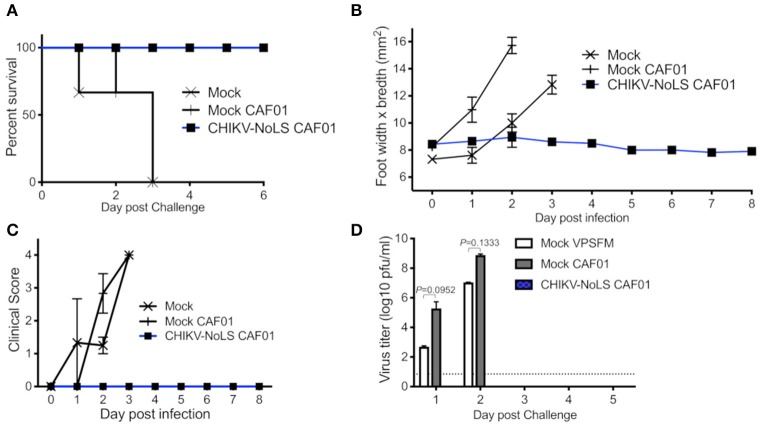
CHIKV-NoLS CAF01 inoculated AG129 mice survive CHIKV-WT challenge and are protected from development of disease. AG129 mice were inoculated with 2 μg CHIKV-NoLS RNA complexed with 0.3 mg CAF01 in the ventral/lateral side of the right foot. Mock inoculated mice received 20 μl VP-SFM media or VP-SFM media containing 0.3 mg CAF01. Mice were challenged with 104 pfu CHIKV-WT subcutaneously in the ventral/lateral side of the right (ipsilateral) foot 30 days post inoculation. Survival curves were constructed (A) as mice were monitored for CHIKV-induced footpad swelling (B), the development of disease signs (C) and changes in weight every 24 h. Disease signs in inoculated AG129 mice were scored on a scale of 0–4 where 4 is humane endpoint. (D) Serum was collected on days 1–5 post challenge and virus titrated by plaque assay. Each symbol represents the mean ± standard error from five to six mice. Statistical analysis was performed by non-parametric Mann–Whitney t-test.